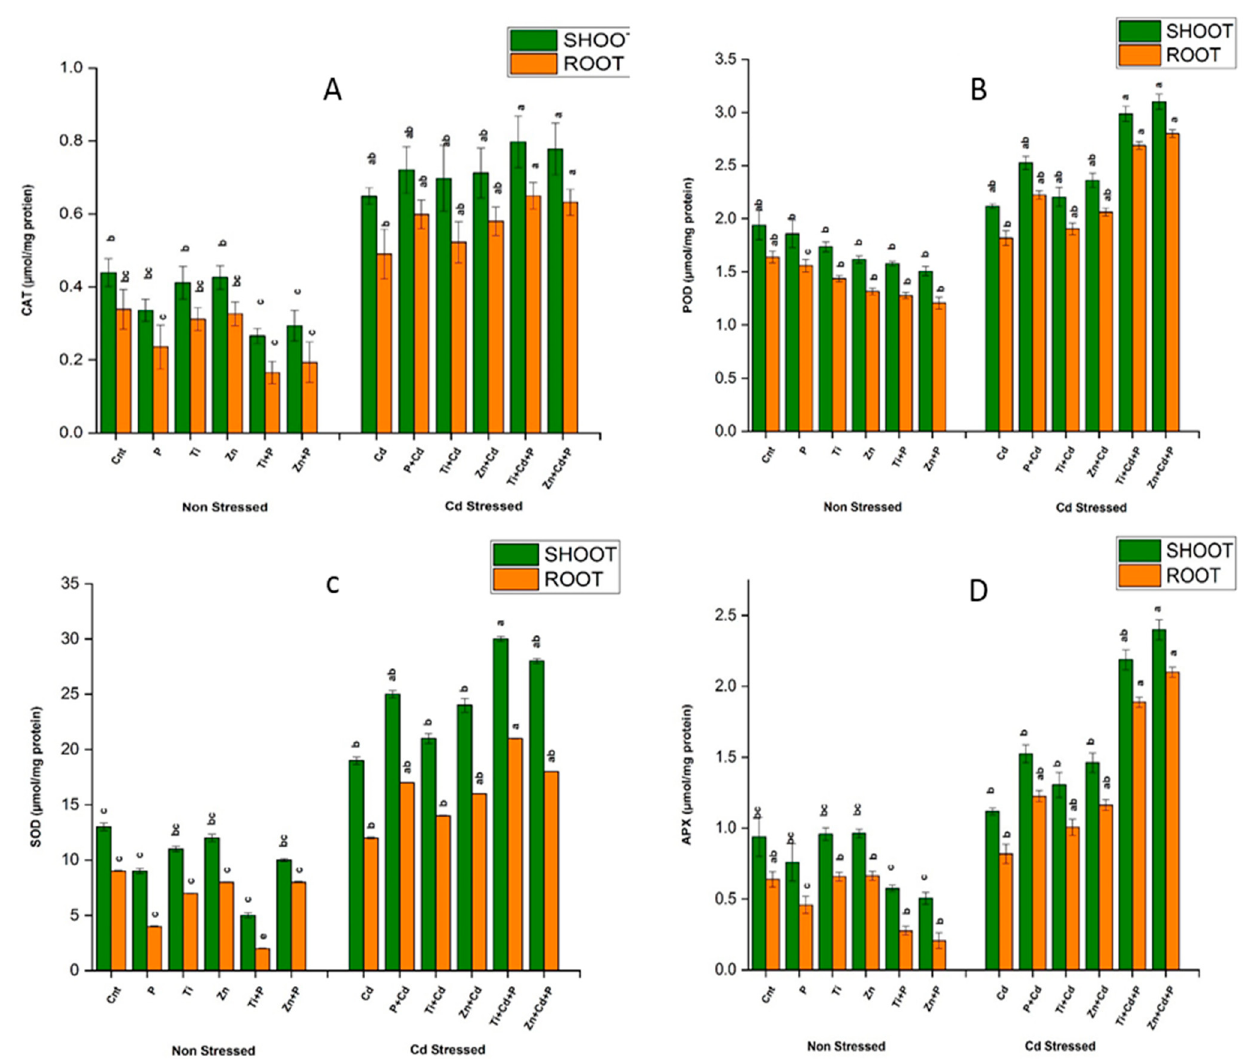
Figure 3. Effects of sole and combined treatments of plant-growth-promoting bacteria (PGPB) ( Bacillus pumilus ) and zinc oxide and titanium dioxide nanoparticles on ( A ) APX content, ( B ) CAT content, ( C ) POD content, and ( D ) SOD content. To compare different mean values of all treatments, the least significant difference (LSD) was computed at p = 0.05.